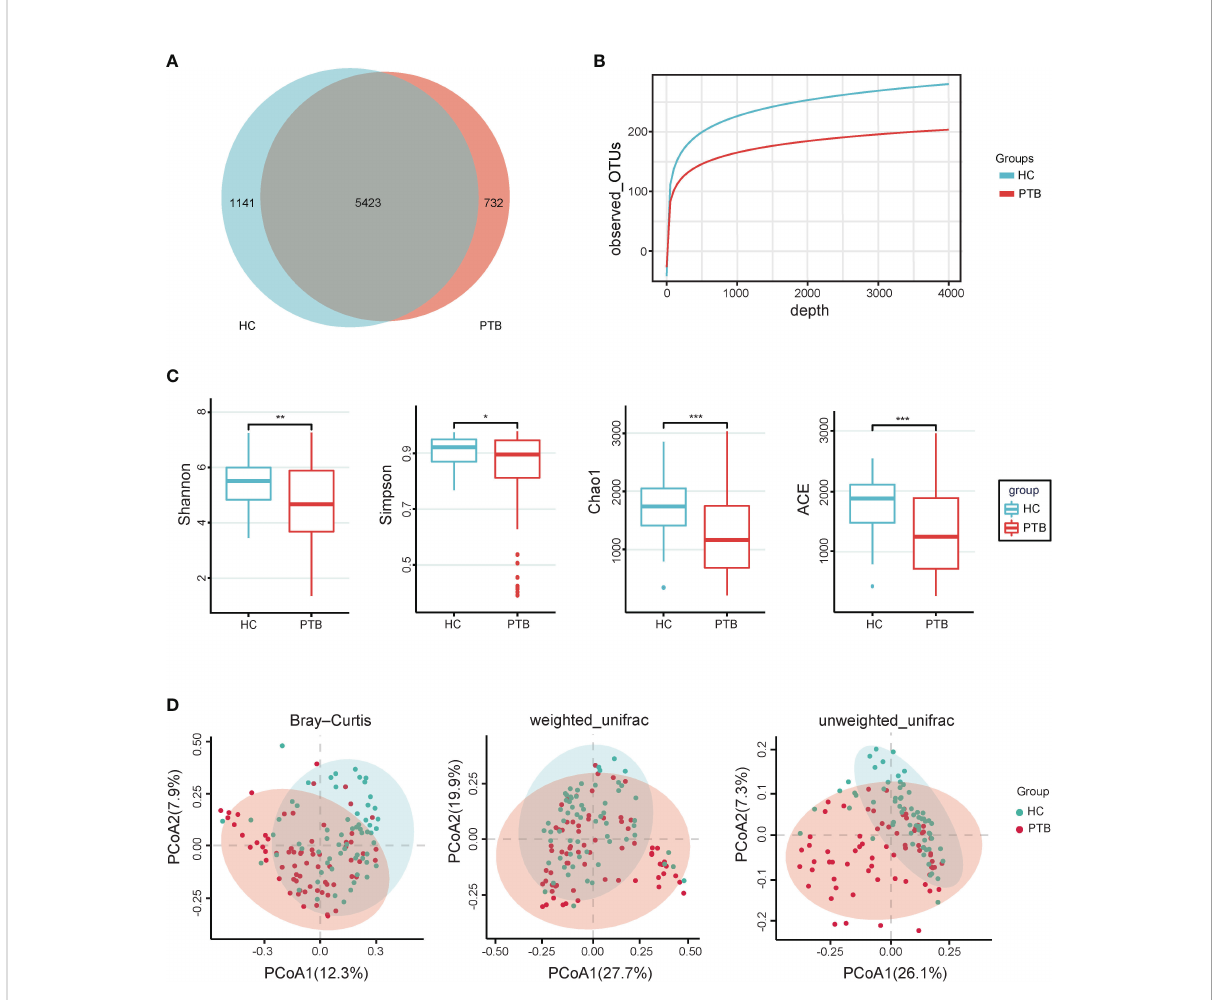
FIGURE 1 Intestinal microbial diversity. (A) Venn diagram showing the shared and unique OTUs in the gut microbiota of the two groups. (B) The rarefaction curves of two groups tended to be fl at, indicating that the amount of sequencing data is large enough to re fl ect the majority of microbial species information in the sample. (C) The alpha diversity was assessed using the ACE, Chao1, Shannon and Simpson indexes, which showed signi fi cant differences between the PTB and HCs groups. * P <0.05, ** P <0.01, *** P <0.001. Wilcoxon rank-sum test followed by Benjamini – Hochberg false discovery rate (FDR) correction. (D) PCoA based on Bray-Curtis, weighted_unifrac and Unweighted_Unifrac distance showed that gut microbiota in PTB separated from HCs ( P <0.05). The signi fi cance was assessed by permutational multivariate analysis of variance (PERMANOVA) using the R package “ vegan ” . PTB, pulmonary tuberculosis; HCs, healthy